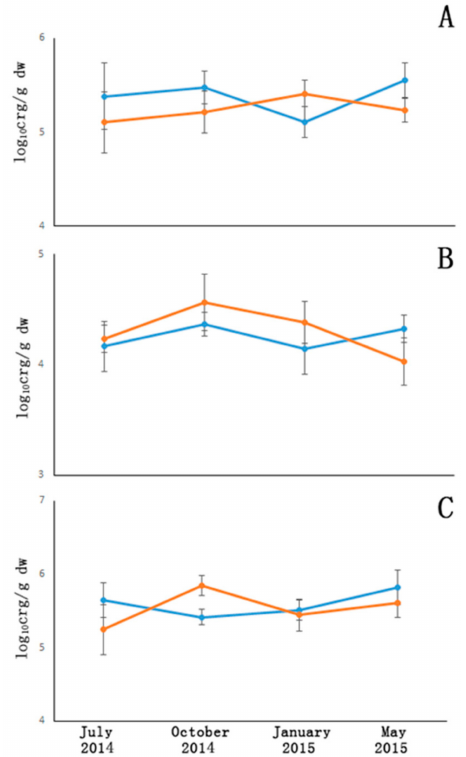
Figure 3. Changes in the numbers of bacteria ( A ), fungi ( B ), and actinomycetes ( C ) in soil adjacent to transgenic and non-transgenic Populus in different sampling time points. No significant differences were detected between the transgenic group and the non-transgenic group at respective samplings points ( α =